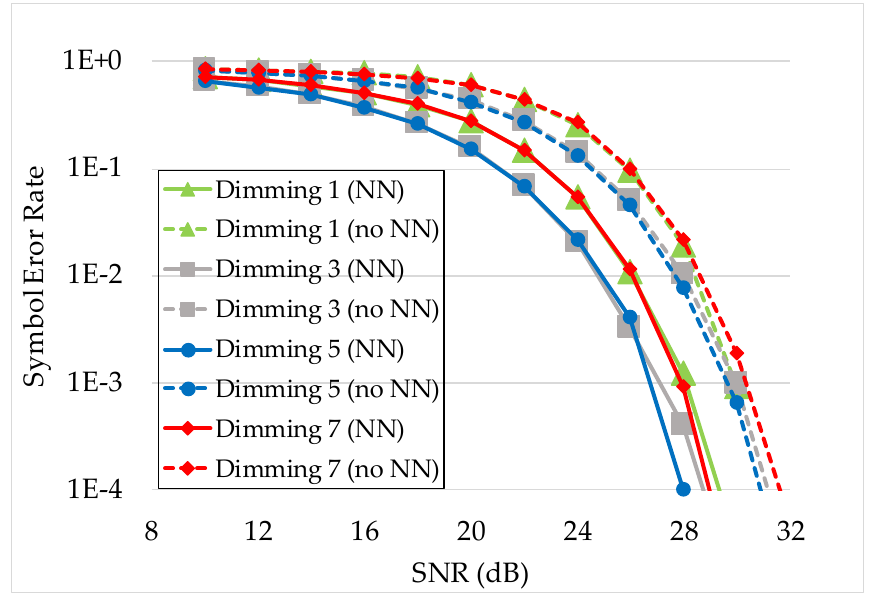
Figure 13. The comparison of SER performance between an NN-based decoder and a matched filter on different dimming cases with a blur kernel size of 60 × 60.